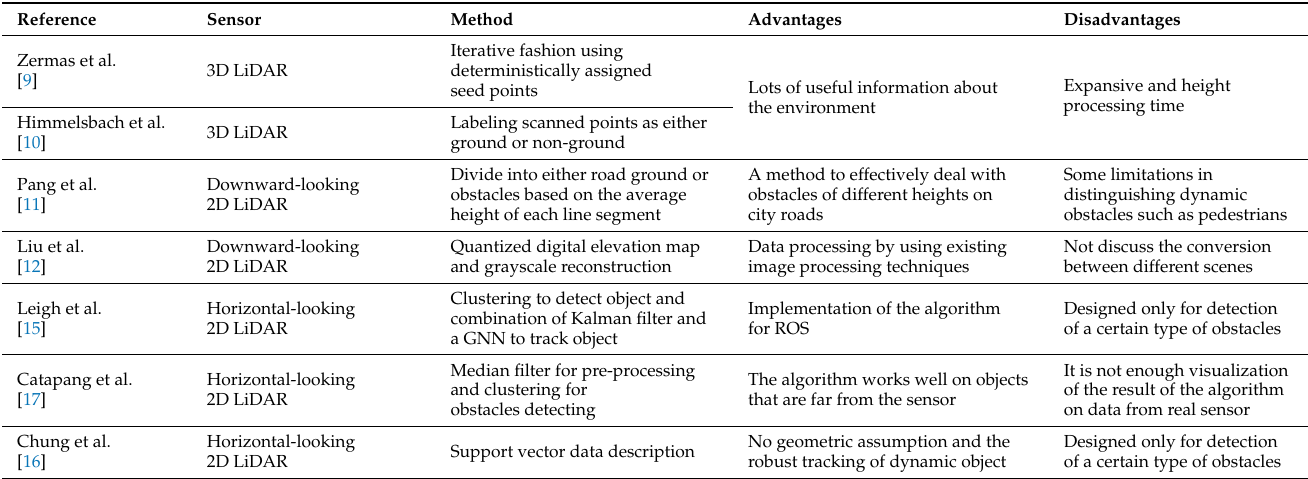
Table 1. An overview of related